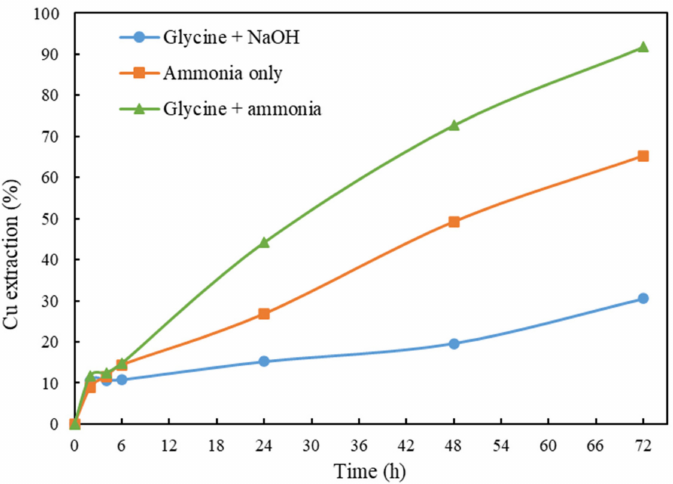
Figure 2. Cu extraction after 72 h of leaching by glycine + NaOH (Gly:Cu = 4:1), ammonia only and glycine + ammonia (Gly:Cu = 4:1). Other conditions: ceramic beads: solid = 3:5, room temperature, rolling speed = 100 rpm, pH = 10.5, 1% solid ratio.